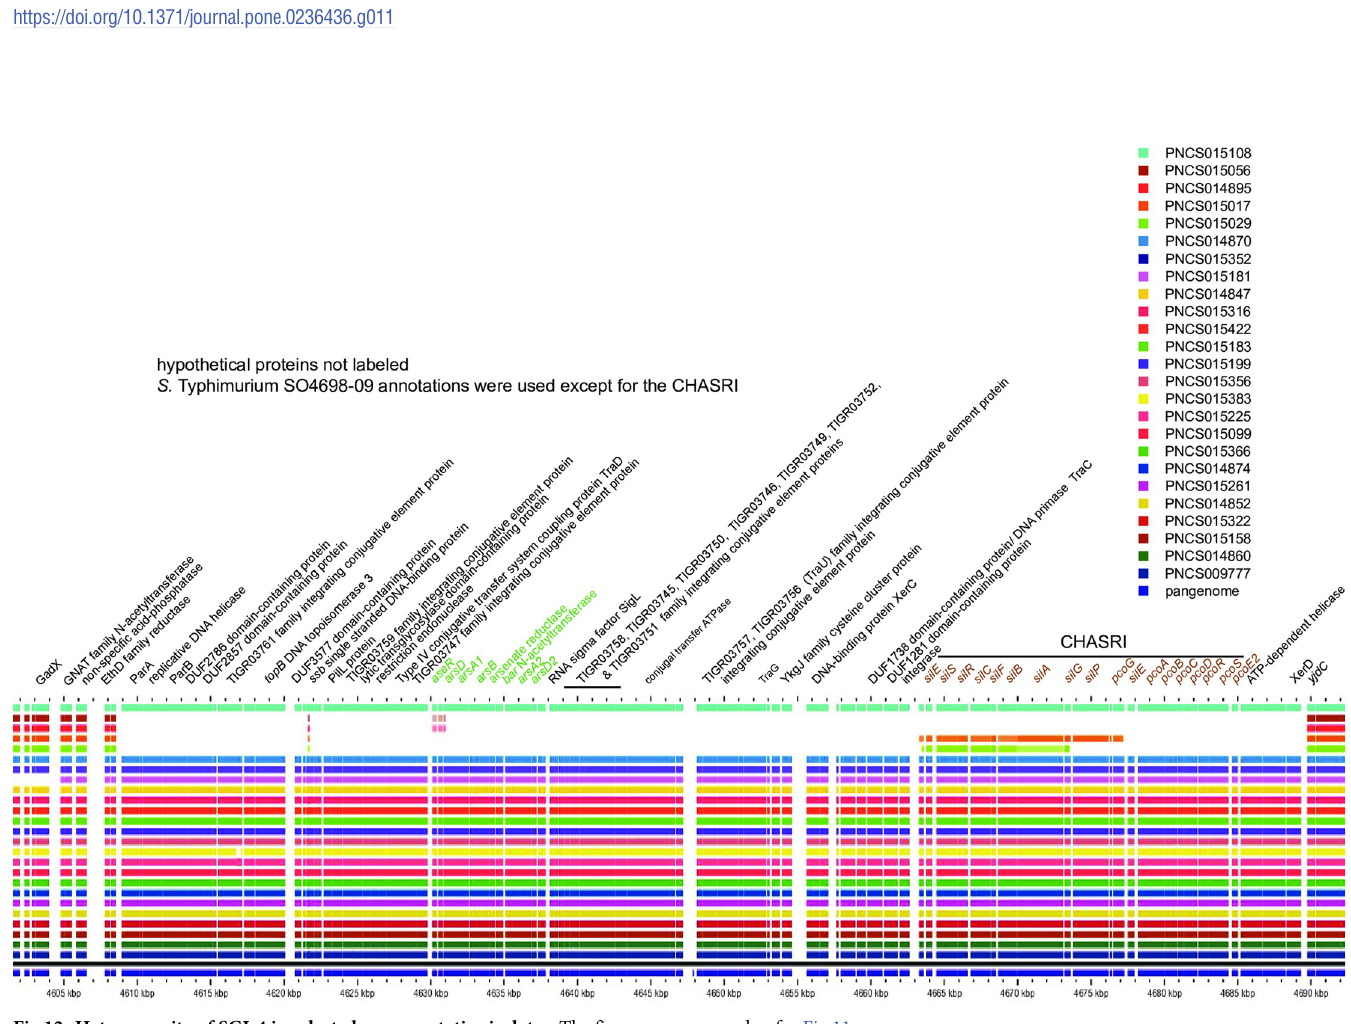
PLOS ONE | https://doi.org/10.1371/journal.pone.0236436 July 27, 2020 17 /